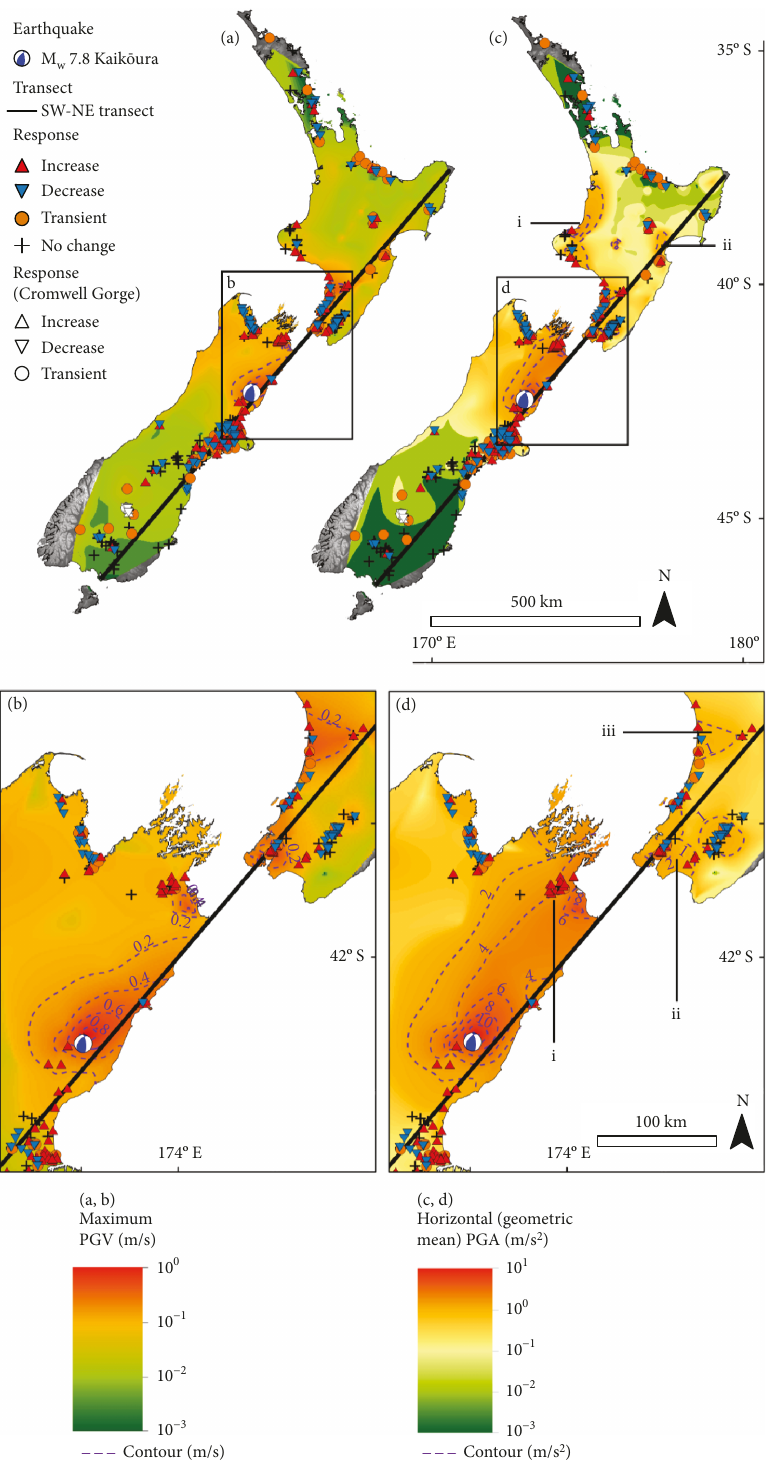
Figure 6: Spatial distribution of water level changes, maximum PGV, and horizontal (geometric mean) PGA induced by the 2016 M Kaik ō ura earthquake. Spatial distribution of the water level changes on a national scale compared to PGV (a) and PGA (c). Notably high levels of shaking occurred in the (i) Taranaki and (ii) Hawkes Bay regions. Spatial distribution of water level changes in central New Zealand as a function of PGV (c) and PGA (d). Notably high levels of shaking occurred in the (i) Marlborough, (ii) Wellington, and (iii) Manawatu-Wanganui regions. Red colours indicate high levels of PGV and PGA; green colours represent low levels of PGV and PGA. A transect through the surface rupture zone and the majority of monitoring wells is shown in Figure